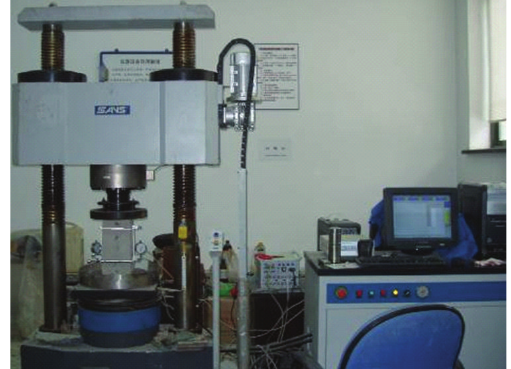
Figure 3: Electrohydraulic servo testing system.